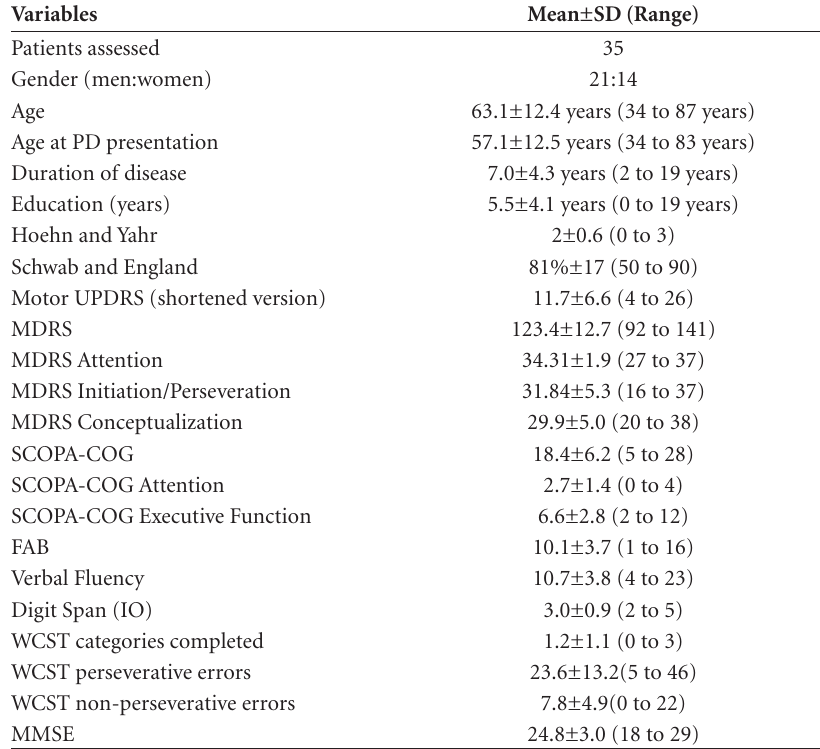
Table 1. Clinical and demographic characteristics, and results of cognitive tests in PD patients.